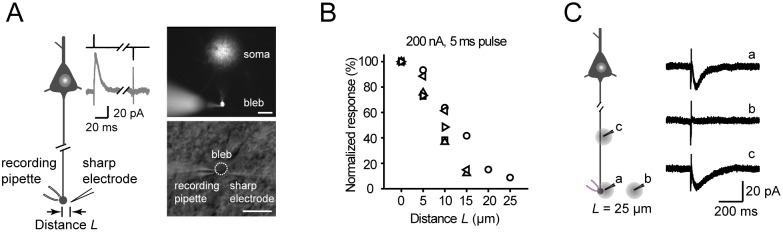
GABA receptors are located at axon bleb and trunk.A, Left, schematic diagram of bleb recording and GABA iontophoresis in a pyramidal neuron. Positive (but not negative) pulses could induce current responses. Vhold = –50 mV; iontophoresis pulses: 200 nA, 5 ms; retention current: –10 nA. Right, whole-cell recording from an axon bleb (top, fluorescence image; bottom, DIC image). Scale bar: 20 µm. The sharp electrode was used for GABA iontophoresis. Alexa Fluor 488 was added to the patch pipette solution so that the recording pipette was visible. B, Plot of the normalized GABA response as a function of the distance between the bleb and the tip of the iontophoresis electrode. Different symbols indicate different cells. The measurement of distance L is shown in the schematic diagram in panel A (indicated by arrows). C, GABA-induced responses could be observed when GABA was applied to the bleb (site a) or the main axon trunk (site c). The distance between sites a and c was approximately 50 µm, whereas that between a and b was approximately 25 µm. Vhold = –80 mV; iontophoresis pulses: 200 nA, 5 ms.